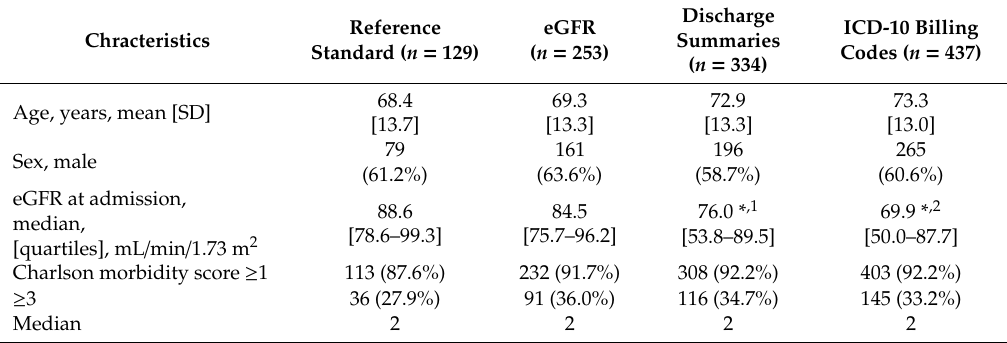
Table 3. Epidemiological characteristics from patients with NKD identified by reference standard or recognized by sources laboratory results (eGFR values), discharge summaries or ICD-10 billing codes.